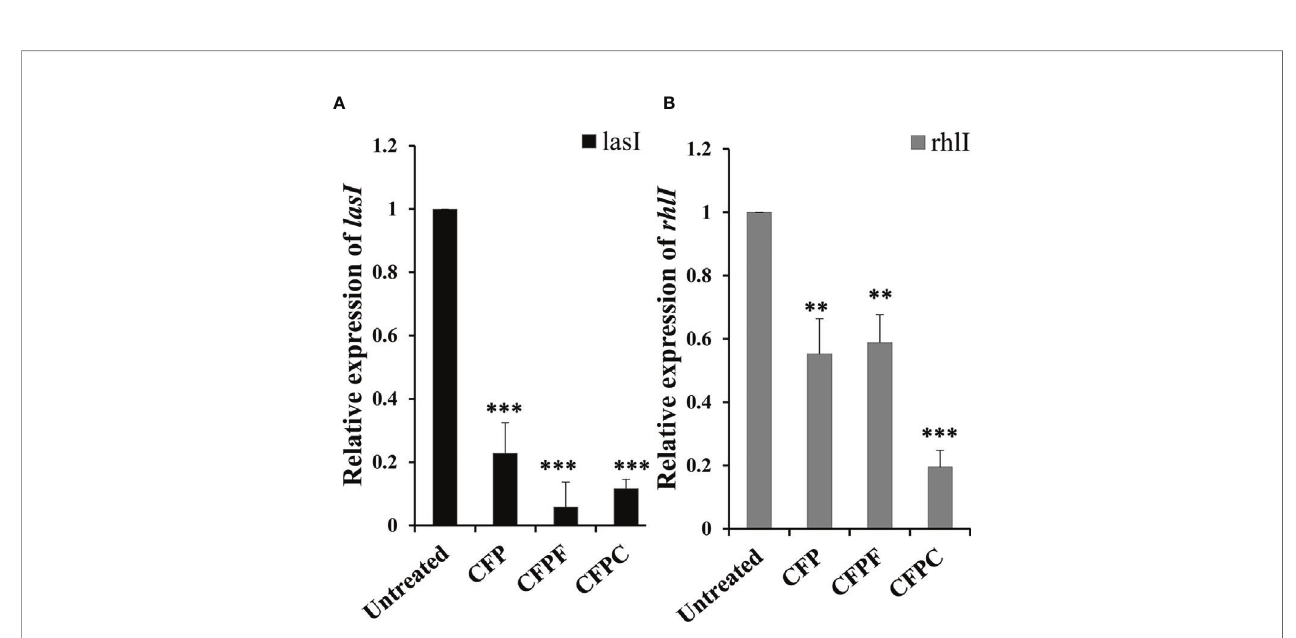
FIGURE 5 | Cefoperazone (CFP), Cefoperazone-Cobalt complex (CFPC) and Cefoperazone-Iron complex (CFPF) at 1/2 MIC inhibited QS regulatory genes (A) lasI and (B) rhlI of P. aeruginosa PAO1 compared to the expression of genes in untreated PAO1. Error bars represent S.D. (n = 3) ** p ≤ 0.01 and *** p ≤